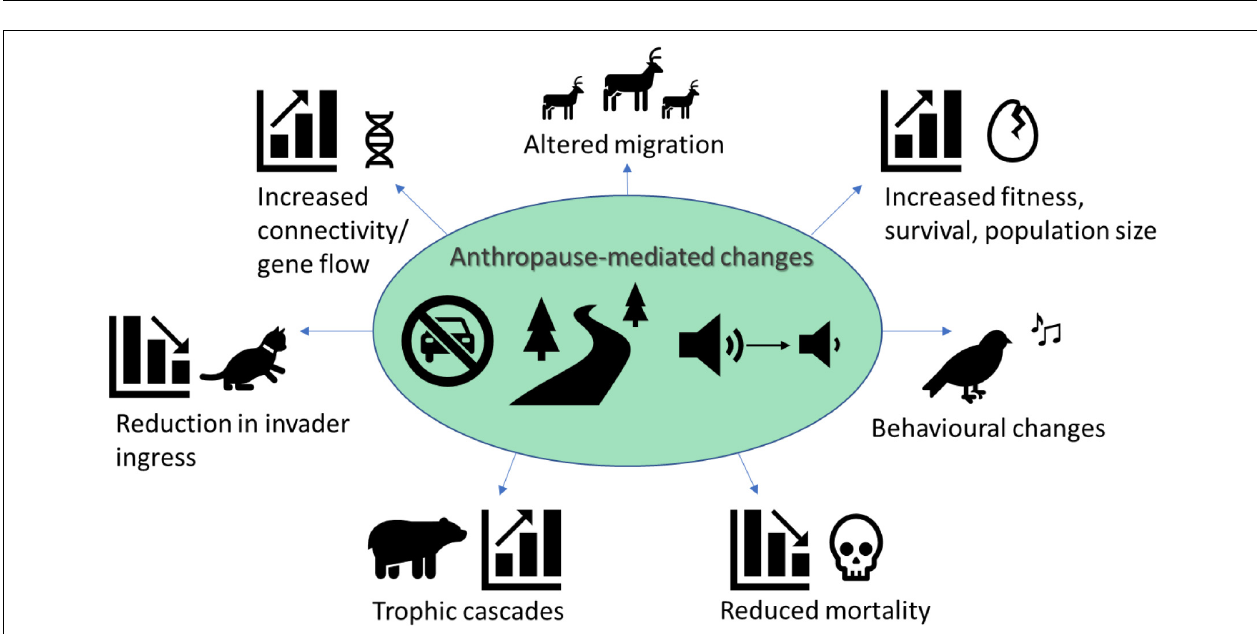
FIGURE 2 | Overview of the anthropause-mediated changes (reduced traffic and noise) and the posited and realized ecological effects of the anthropause on wildlife-vehicle conflicts (WVC). To date, reductions in mortality (Manenti et al., 2020; Bates et al., 2021; Bil et al., 2021; Driessen, 2021; LeClair et al., 2021; Shilling et al., 2021; Łopucki et al., 2021) and behavioral changes (Derryberry et al., 2020) have been observed due to anthropause mediated reductions in traffic volume and traffic noise, respectively.